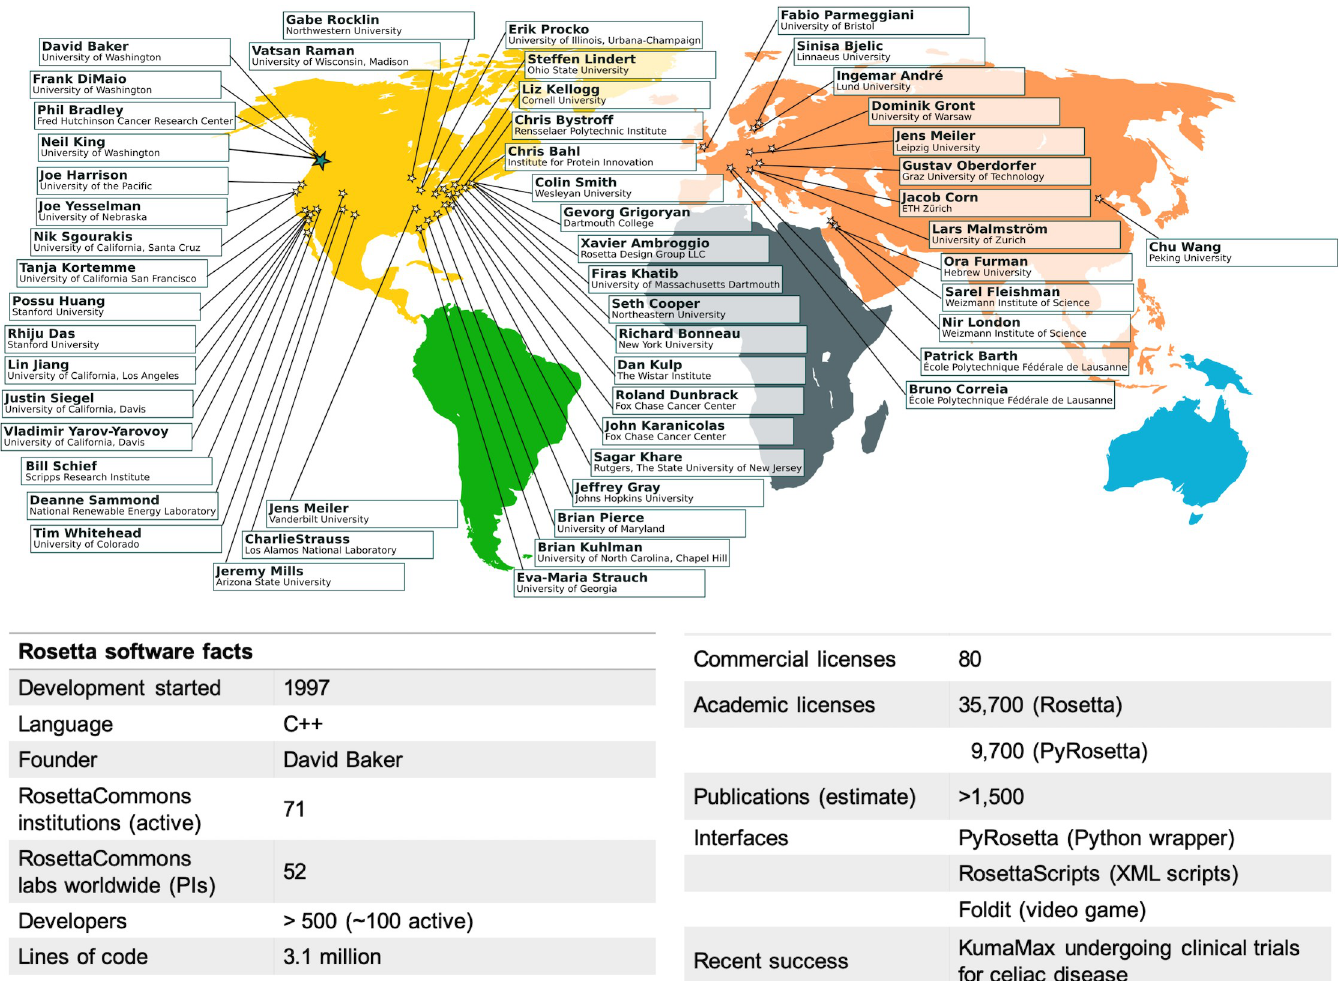
Fig 1. RosettaCommons facts. Main laboratories and institutions in the RosettaCommons and basic facts about our software in 2019.